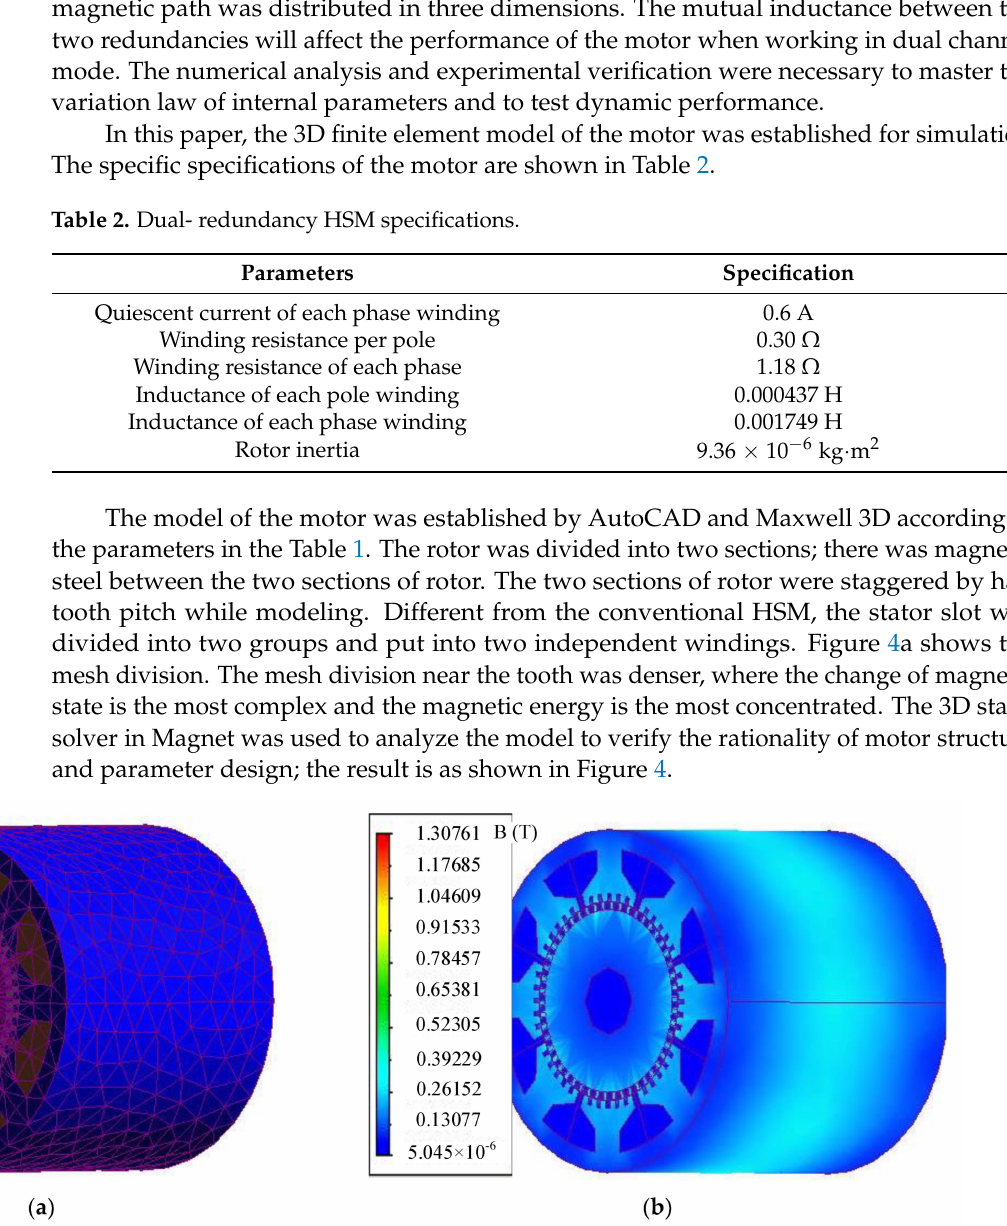
Figure 4. Mesh shape and distribution of magnetic flux density. ( a ) Mesh division of the dual-redundancy HSM. ( b ) Magnetic flux density of the dual-redundancy HSM.